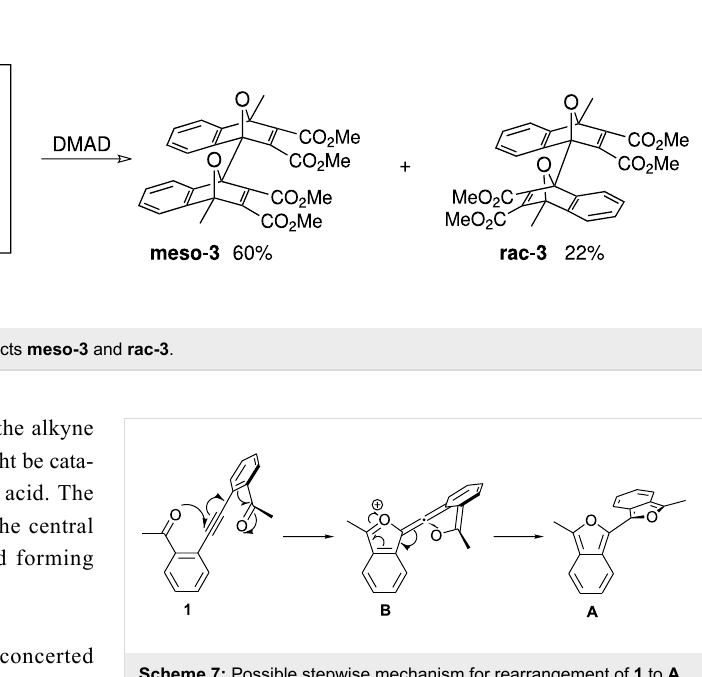
Scheme 7: Possible stepwise mechanism for rearrangement of 1 to A .